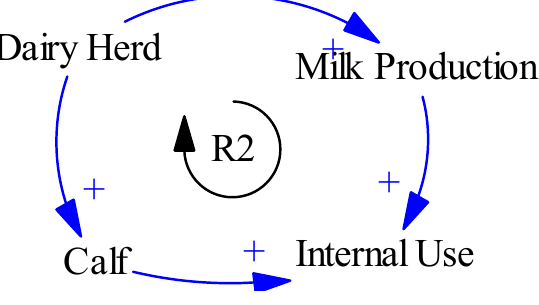
Figure 4. Production loop.